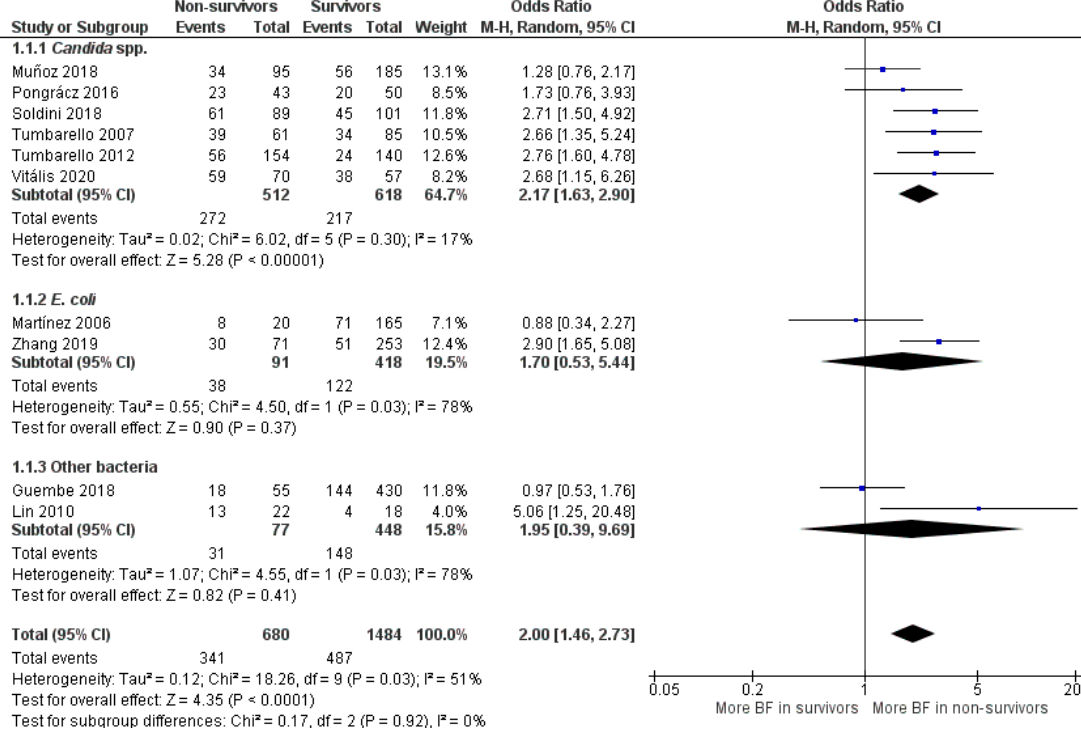
Figure 5. Forest plot of BFP (biofilm production) prevalence in BSIs (Bloodstream Infections) non-survivors vs. survivors and subgroup analysis by microorganism. “Tau 2 ” represents the absolute value of the true variance (amount of heterogeneity). “Chi 2 ” is the chi-squared test of the null hypothesis that there is no heterogeneity. “df” are degrees of freedom. “P” represents the p -value. The “I 2 ” statistic describes the percentage of variation across studies that is due to heterogeneity rather than chance. “Z” is the z-statistic, which are significance tests for the weighted average effect size. “CI” stands for confidence interval. “M-H” is the Mantel-Haenszel analysis